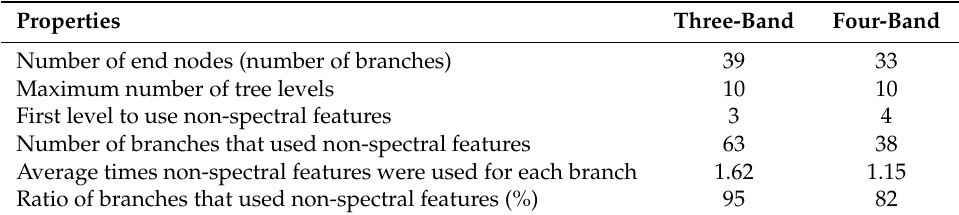
Table 7. Statistical results of decision tree models for object-based classification.